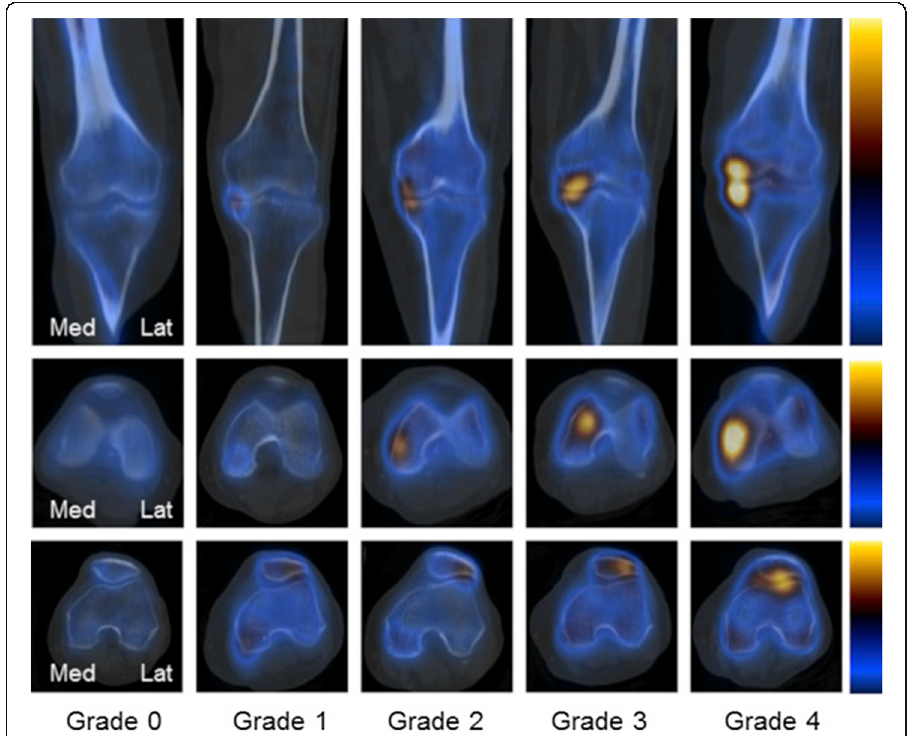
Fig. 2 Kim et al. demonstrated a strong correlation between quantitative bone SPECT results and results from visual grading for patients with osteoarthritis of the knee (Kim et al. 2017). (Permission to reuse this figure was reached in agreement with Elsevier on 28th March